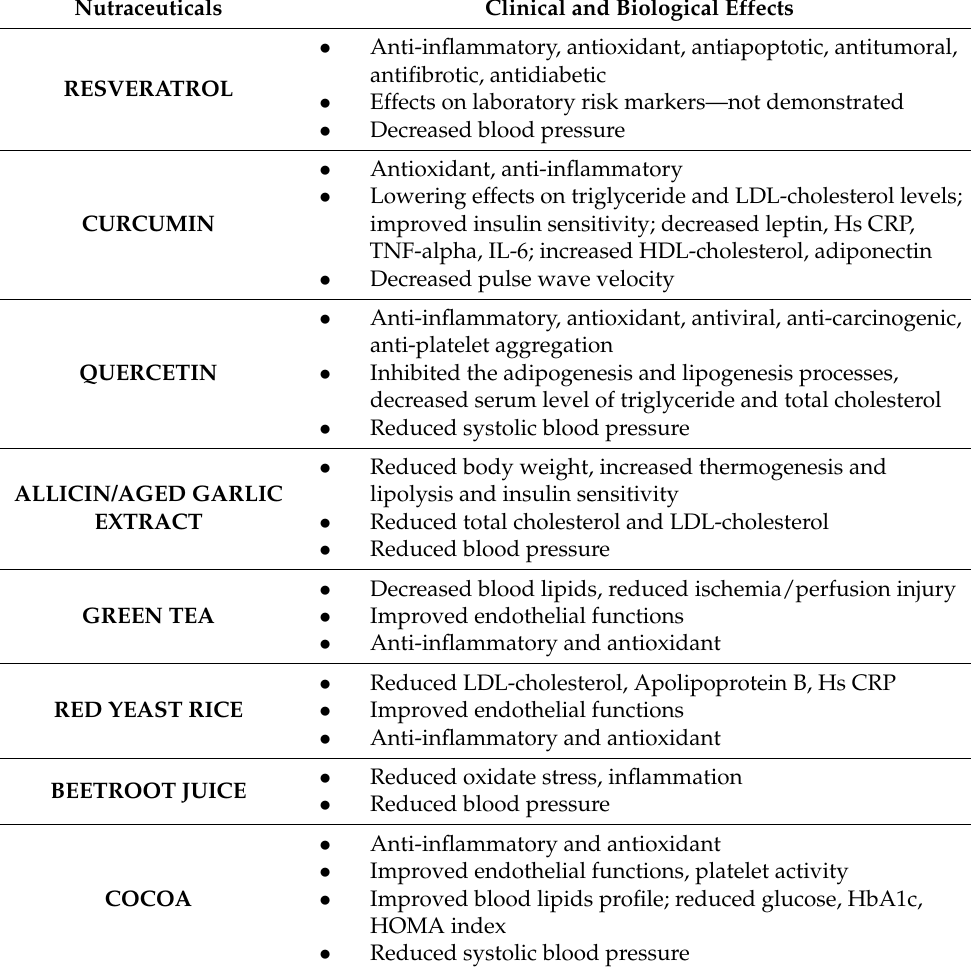
Table 3. Nutraceuticals with potential benefits in reducing cardiovascular risk factors